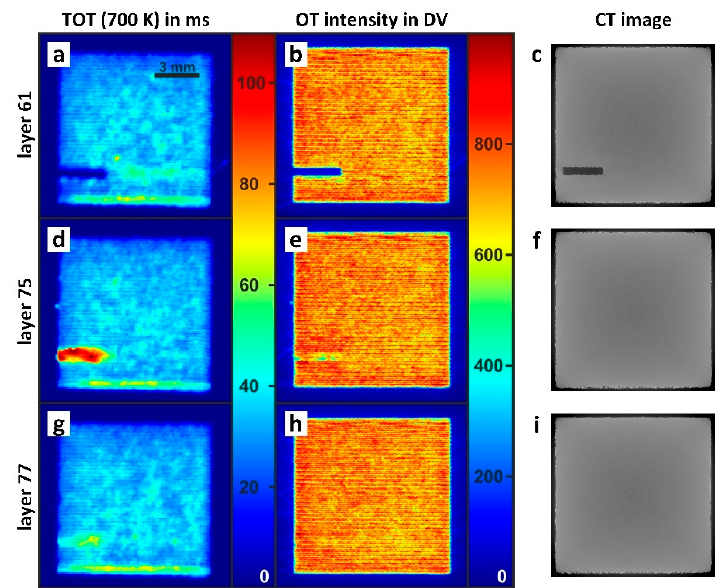
Figure 10. Comparison of data from in-situ monitoring with µCT data for an artificial defect (cavity): ( a – c ) show layer 61 where the cavity is not exposed; ( d – f ) show layer 75, which is the first fully exposed layer on top of the cavity; ( g – i ) show layer 77 as third layer above the cavity.